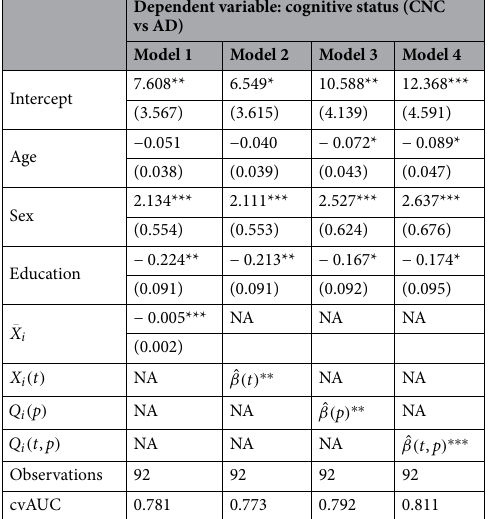
Table 2. The p values for β( t ) and β( p ) in SOFR correspond to the p values from global test of these coefficients and are as reported by the pfr function for scalar-on-function regression within the refund package 50 in R 51 . These are based on a test statistic motivated by an extension of Nychka’s analysis 52 of the frequentist properties of Bayesian confidence intervals for smooths 53 . The p values for β( t , p ) are based on a likelihood ratio test (LRT) (of inclusion) in the second stage of the estimation process with the selected components of W coming from the first stage.